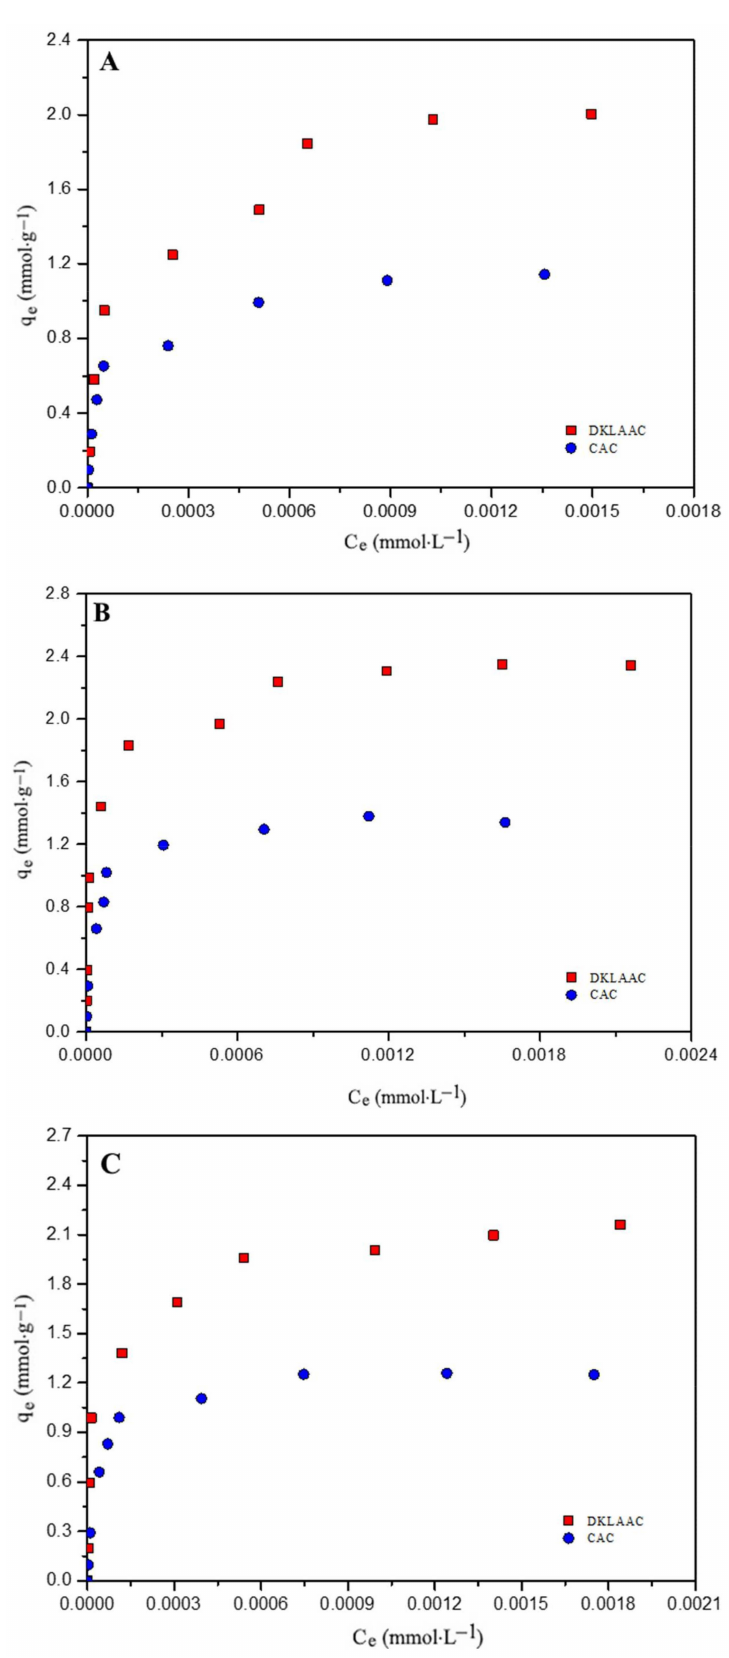
Figure 3. Adsorption isotherms for the removal of phenol ( A ), 2-NP ( B ), and 4-NP ( C ) by DKLAAC and CAC at 25 ◦